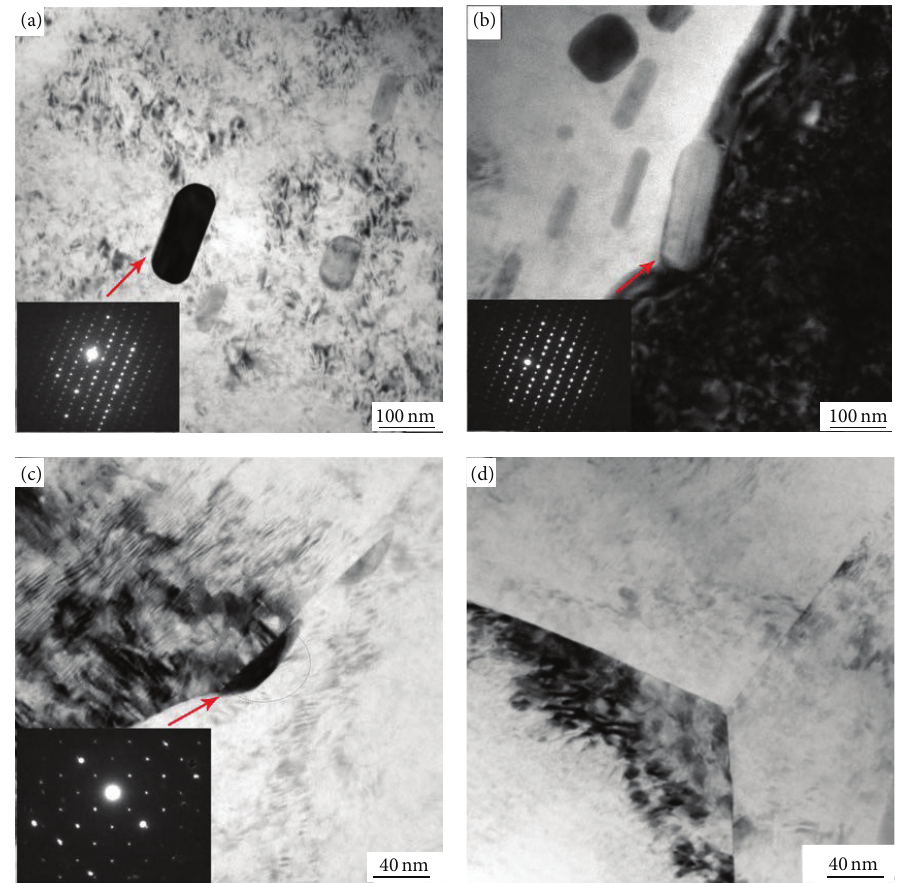
Figure 2: TEM images of the intermetallic precipitates in the matrix (a), along the grain boundaries (b, c) and the clean grain boundaries (d).